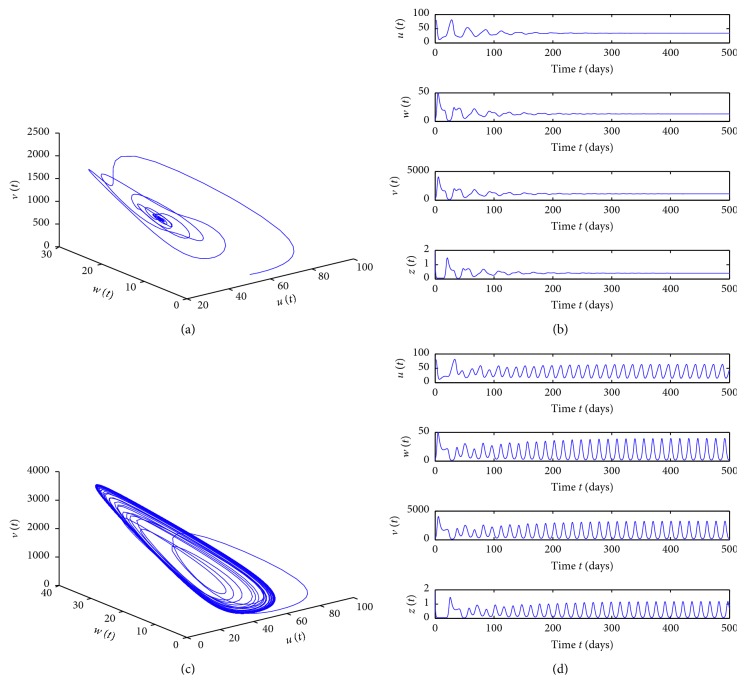
Solutions of the model for τ=15 (a, b) and τ=20 (c, d), corresponding to Figure 1(b).